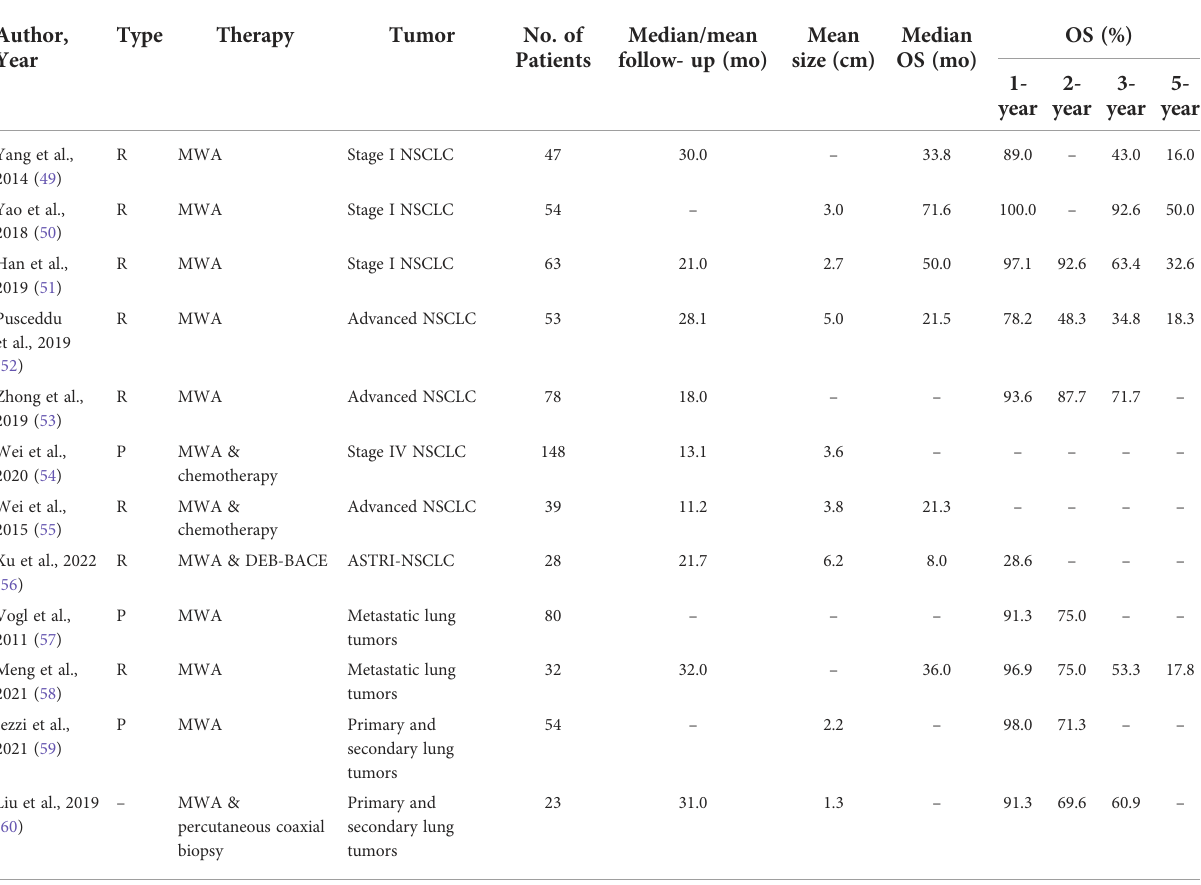
TABLE 2 Summary of published studies of MWA in lung